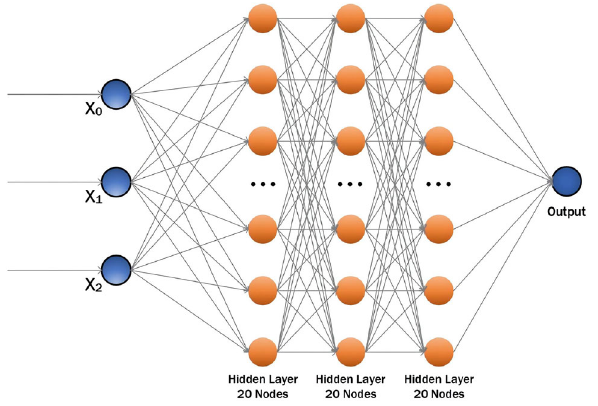
Fig. 5 Structure of the neural network model